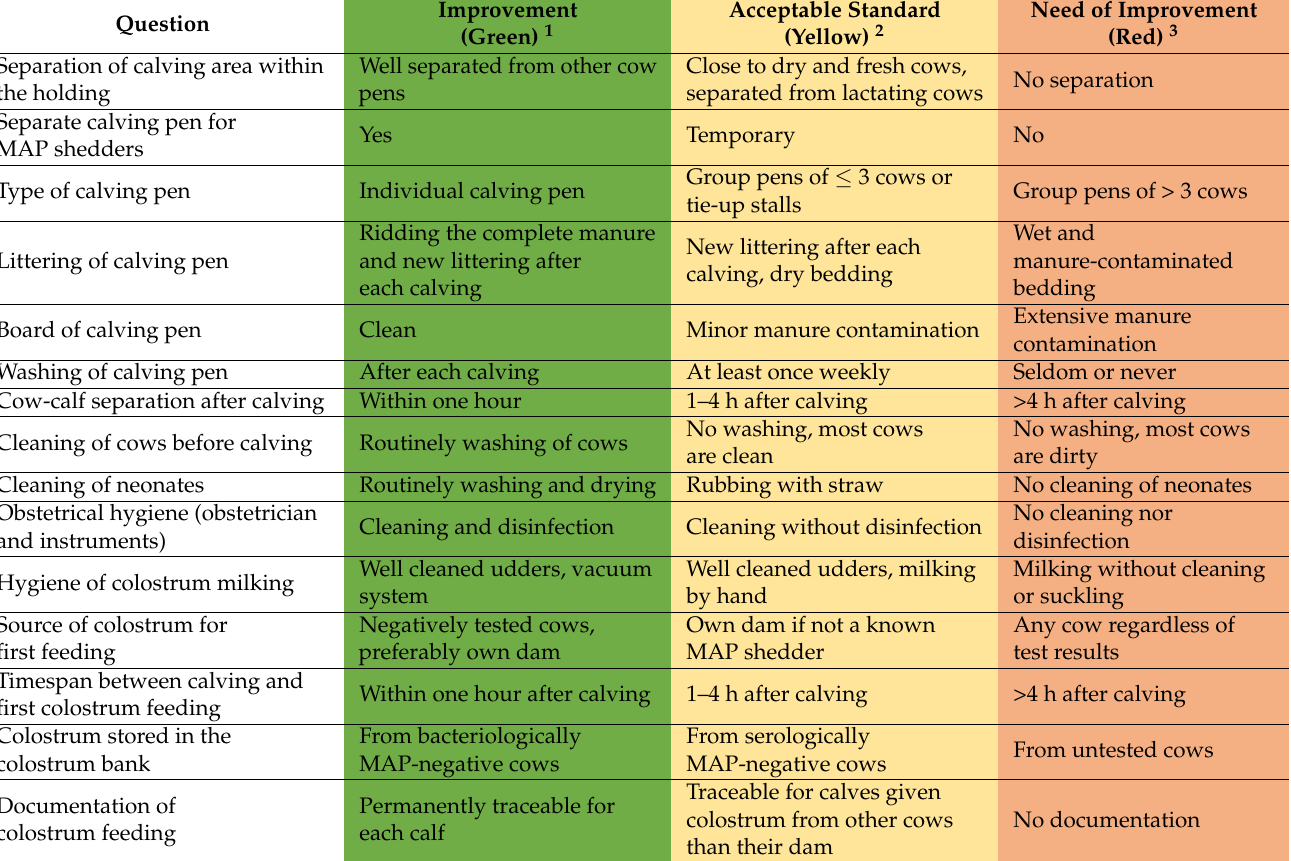
Table A1. Purpose-made questionnaire used by the specialized veterinarians from the Animal Health Service to systematically review the biosecurity risks of JD within a dairy